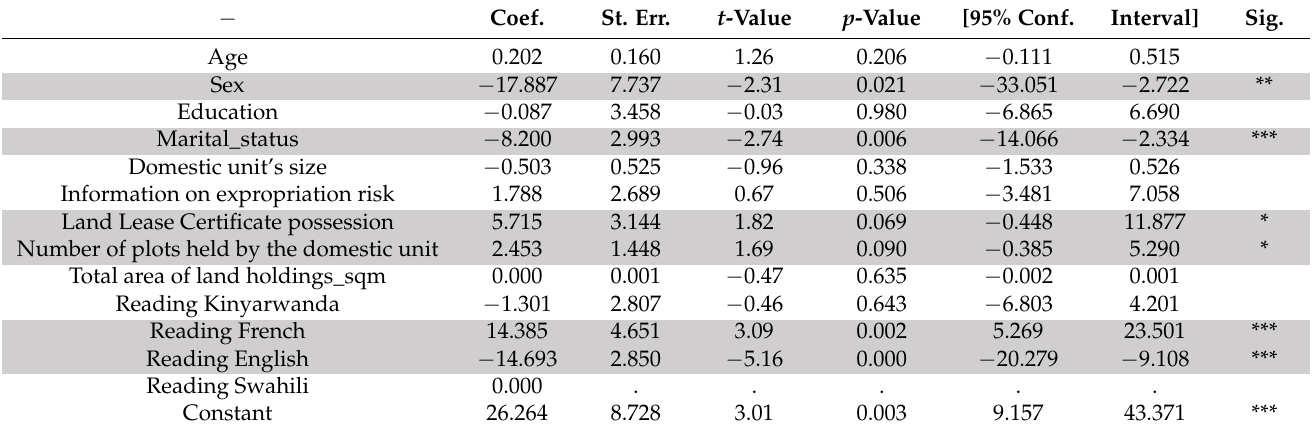
Table 5. Factors affecting the decision of the head of a domestic unit to have a principal activity with a self-employment